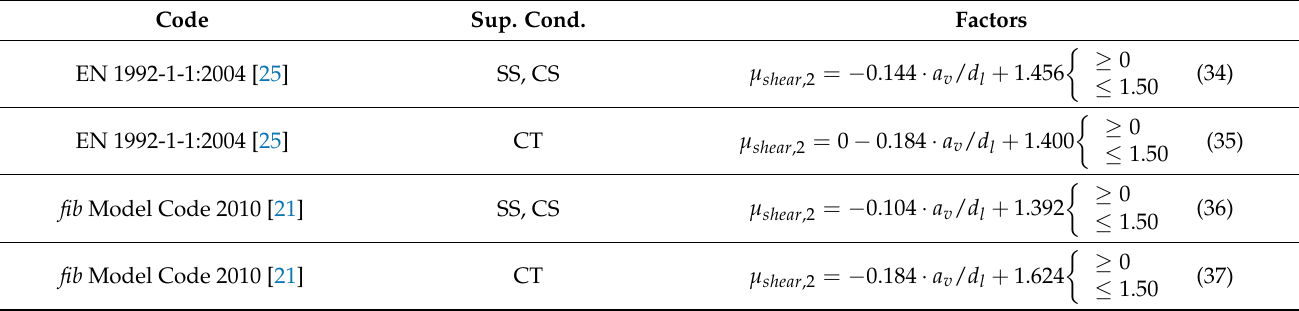
Table 2. Factors µ shear ,2 to correct the predicted effective shear width with the French approach when using different codes and support conditions. Note: Sup. Cond = support condition close to the load; SS = simple support (hinged support); CS = continuous support; CT = cantilever slab. Code Sup. Cond.